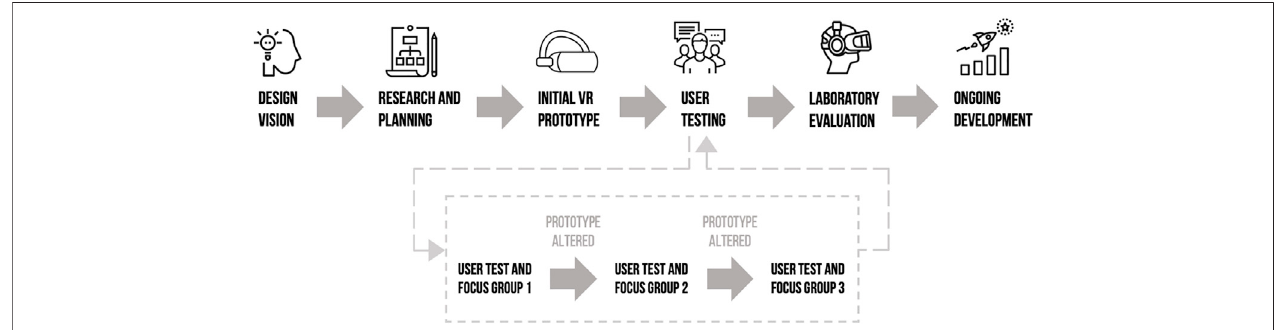
FIGURE1| Illustrationofstagesinthedesignanddevelopmentprocessforthe Place VRmindfulnessapp.Thispaperdescribesactivitiesundertakenfromoutlining the initial design vision through to user testing and iterative improvement of the VR prototype based on participants ’ feedback. Information on the laboratory evaluation can be found in (Seabrook et al.,